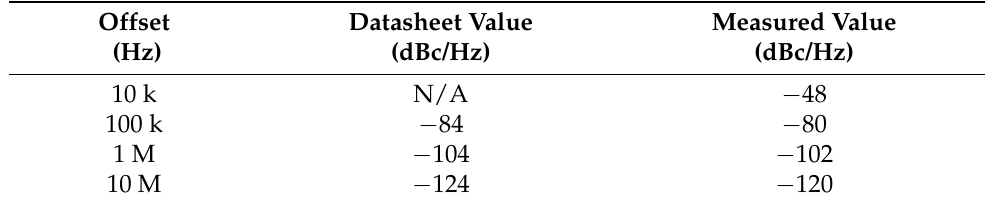
Table 2. Phase noise of the BGT60 transmitter at 60